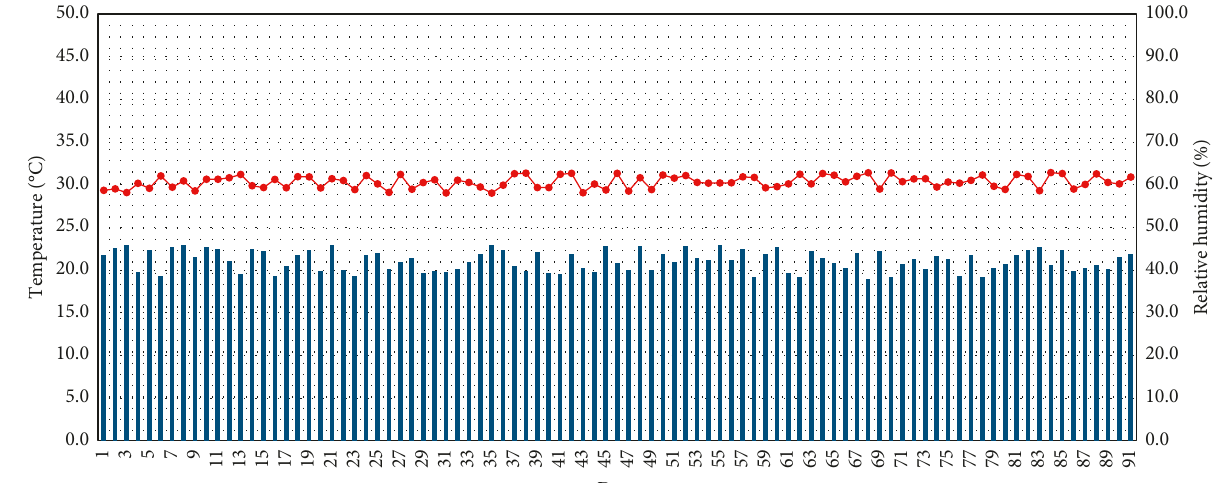
Figure 6: Curing conditions (the first part of UHPC specimens).